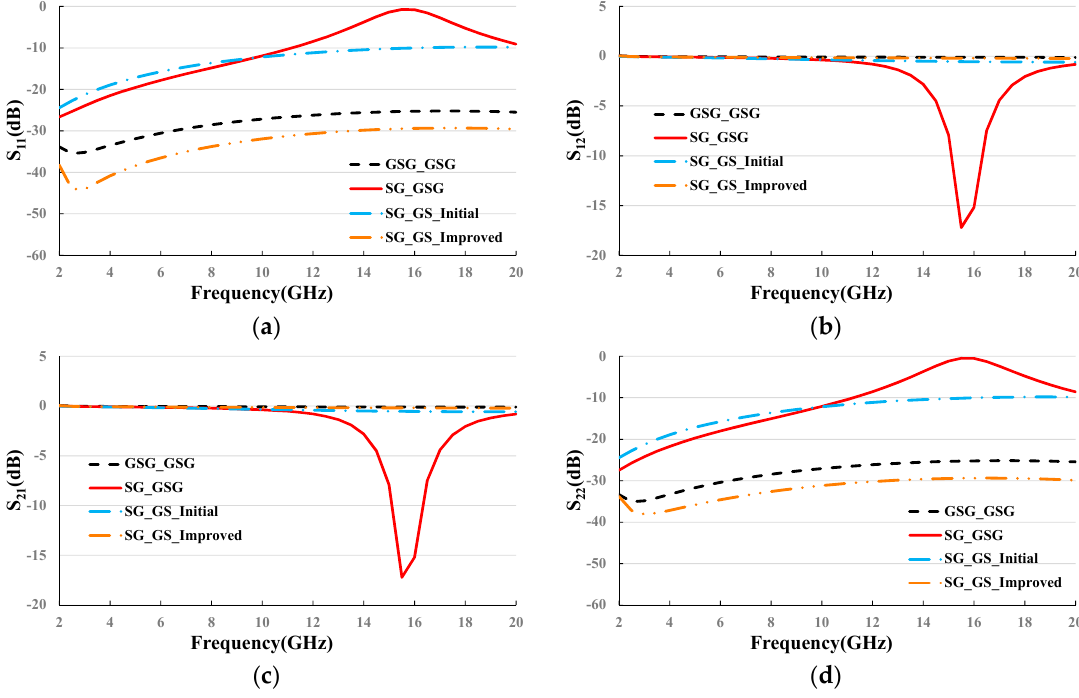
Figure 5. Simulated S-parameter comparison of thru with different types of probes, while ( a ) represents GSG-GSG model; ( b ) represents SG-GSG model; ( c ) represents initial SG-GS model; ( d ) represents improved SG ‐ GS model.